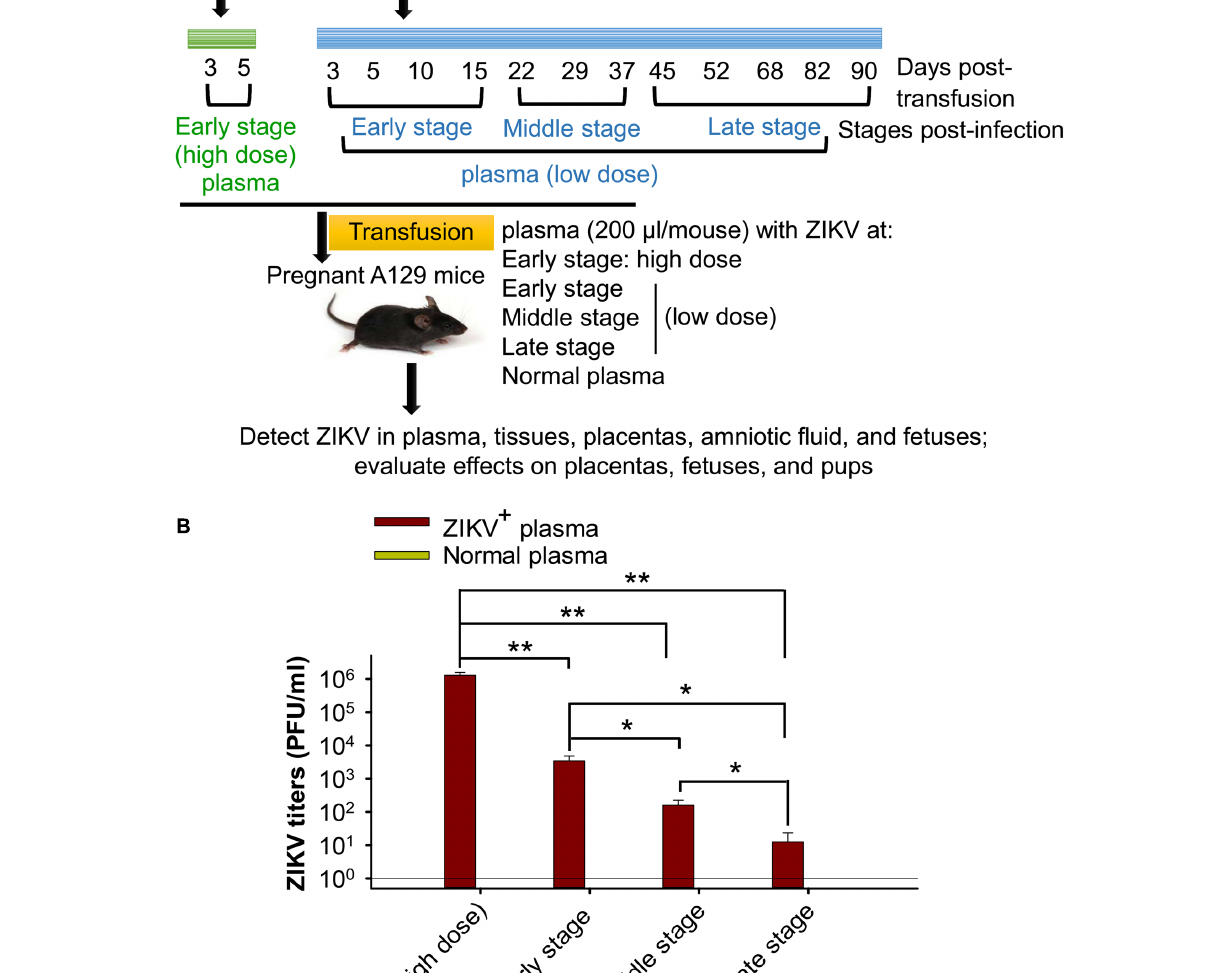
reverse (5 (cid:48) -CCTTCCACAAAGTCCCTATTGC-3 (cid:48) ) primers were used for the amplification. To establish a standard